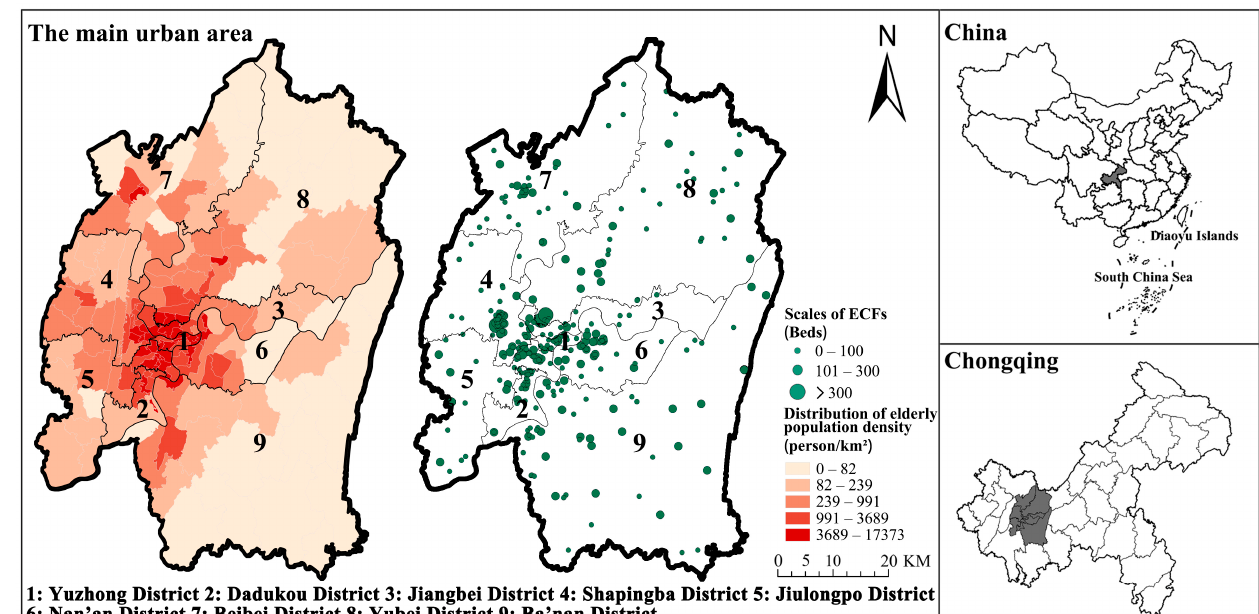
Figure 2. The geographical distribution of elder population density and ECFs in the main urban area of Chongqing.